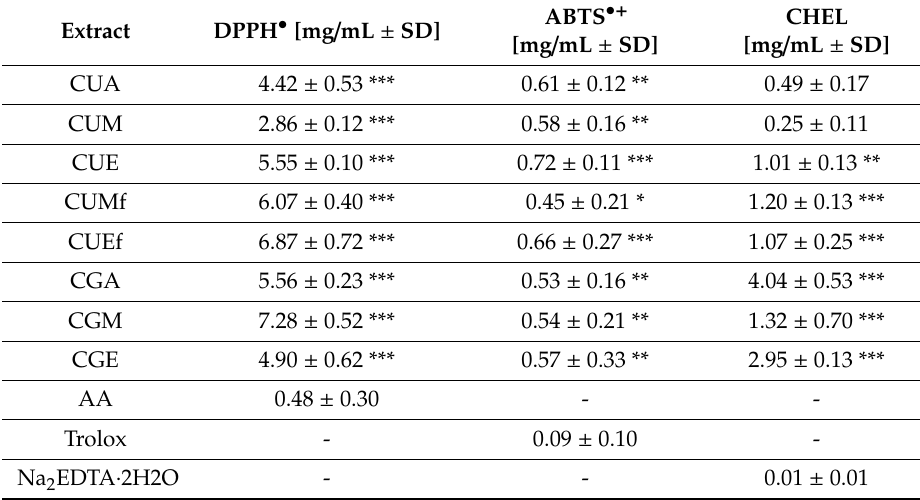
radicals and their ferric ion-chelating capacity